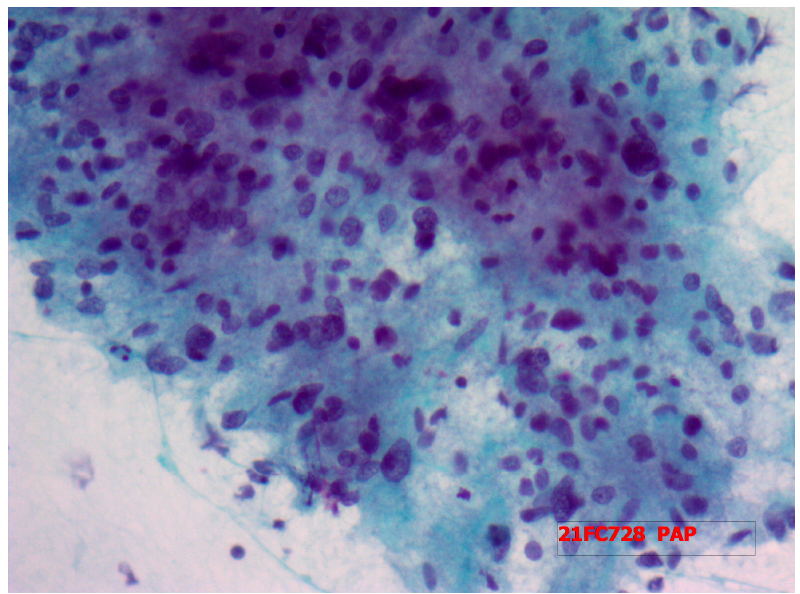
Figure 3. Fine-needle cytology of the neck lesion microscopically highlighting the presence of a three-dimensional solid group of fused cells in a hemorrhagic background, immersed in a metachromatic matrix, in the absence of a colloid component.